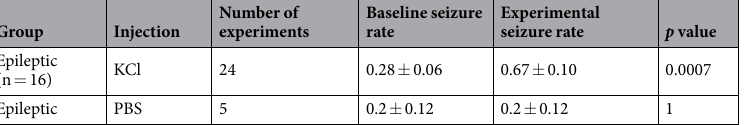
Table 3. Seizure rate. Mean seizure rate for each experiment (in seizures/hour), for 3-hour intervals during and before the experiment. The potassium chloride (KCl) injections induced an increased seizure rate, while there was no effect from PBS injections.